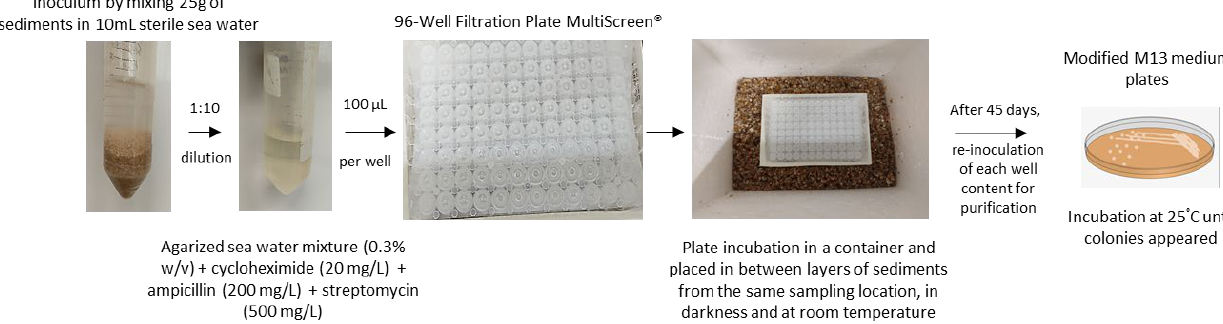
Figure 1. Brief description of the iChip inspired culturing system used in this study for planctomycetes isolation from marine sediments retrieved from Memória beach (Portugal).